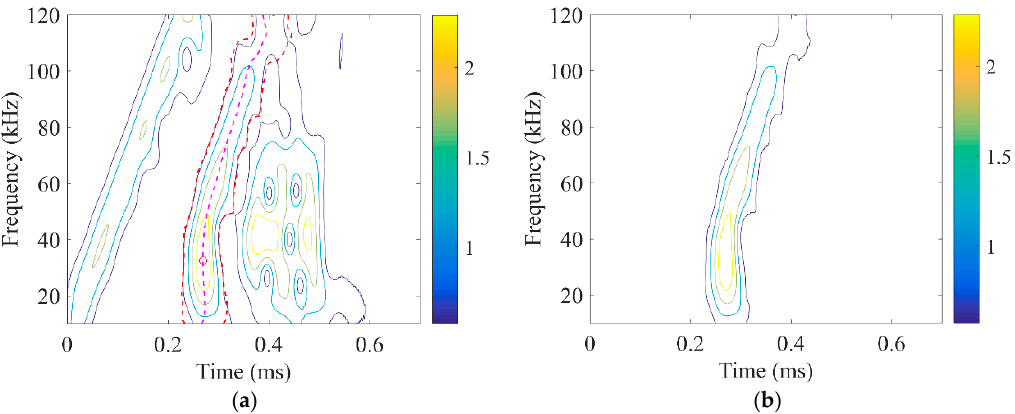
Figure 8. The short-time Fourier transform (STFT) spectrogram of ( a ) the response signal and ( b ) the filtered direct wave of A0 mode.